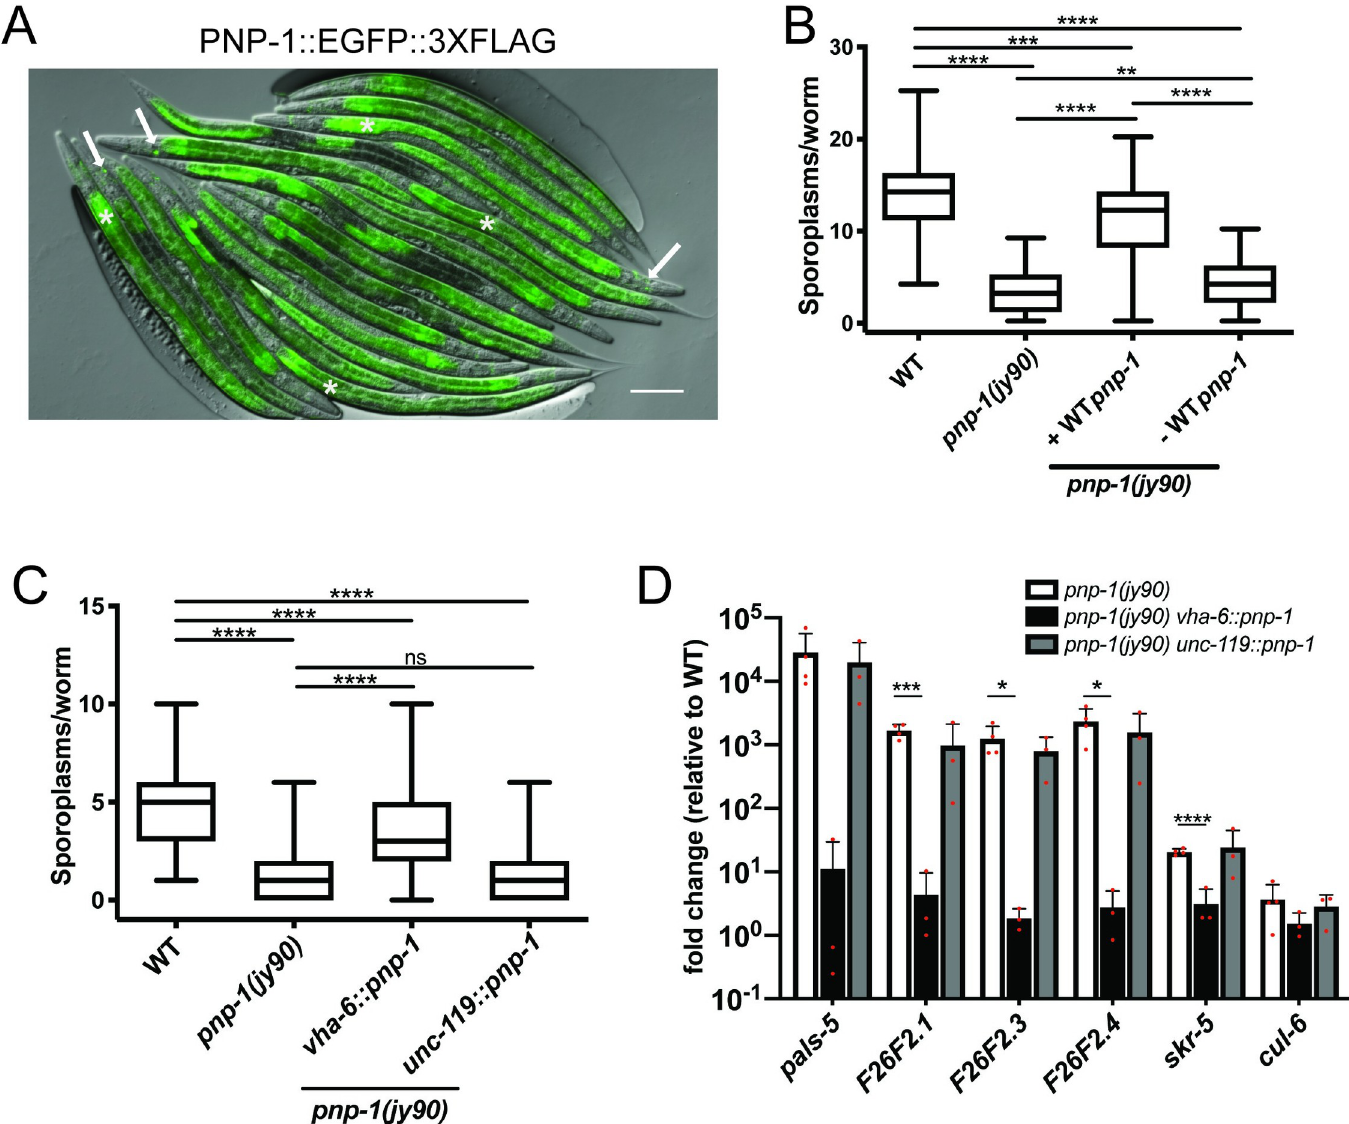
Fig 3. pnp-1 functions in the intestine to regulate the IPR. A) Expression of PNP-1::EGFP::3XFLAG under control of the wild-type pnp-1 genomic locus. Asterisks indicate intestines and arrows indicate neurons. Scale bar is 100 μ m. B) Quantification of N . parisii sporoplasm number at 3 hpi in pnp-1 mutants containing the rescuing pnp-1 :: egfp :: 3Xflag genomic locus in L1 animals (indicated as "+WT pnp-1 "), as well as their non-transgenic siblings (indicated as "-WT pnp-1" ). n = 255 animals per genotype. C) Quantification of N . parisii sporoplasm number at 3 hpi in pnp-1 mutants containing wild-type pnp-1 cDNA under the control the vha-6 (intestinal) or unc- 119 (neuronal) promoters in L1 animals. n = 150 per genotype. B, C) N . parisii was visualized using an N . parisii rRNA specific probe. Each graph shows the combined results of three independent experiments. In the graphs, the box represents the 50% of the data closest to the median while the whiskers span the values outside the box. ���� indicates p < 0.0001 by the Kruskal-Wallis test. D) qRT-PCR of a subset of IPR genes in adult pnp-1 mutants containing wild-type pnp-1 cDNA under the control the vha-6 or unc-119 promoter. Fold change in gene expression is shown relative to control. Graphs show the combined results of three independent experiments. Red dots indicate values from individual experiments. ���� indicates p < 0.0001 by a one-tailed t-test. https://doi.org/10.1371/journal.ppat.1009350.g003 PLOS Pathogens| https://doi.org/10.1371/journal.ppat.1009350 April 20,